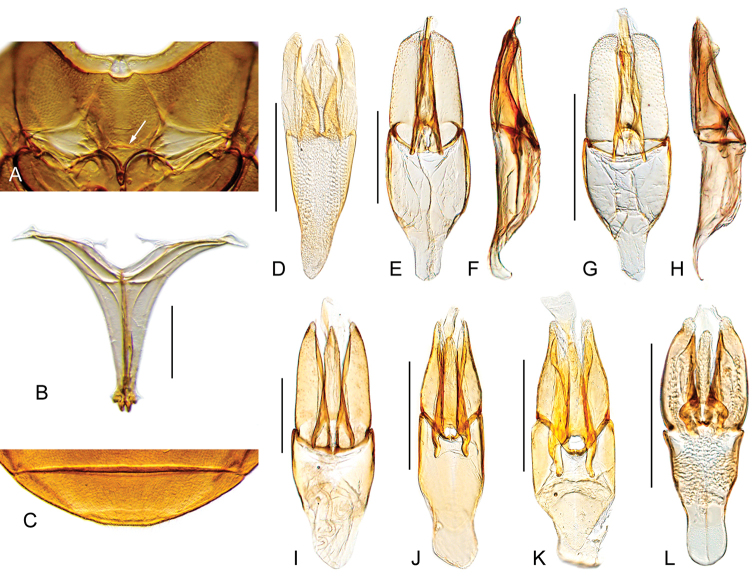
Thorax, abdomen and aedeagus of Primocerus spp.: A–DPrimocerusneutrum: A ventral view of mesoventrite (white arrow pointing transverse ridge) B posterior view of metafurca C fifth abdominal ventrite D aedeagus. E–L aedeagus: E, FPrimocerusmaipure: E dorsal view F lateral view. G, HPrimoceruspijiguaense: G dorsal view H lateral view IPrimocerusgigasJPrimoceruspetilusKPrimocerusstriatolatusLPrimoceruscuspidis. Scale bars: 0.25 mm.